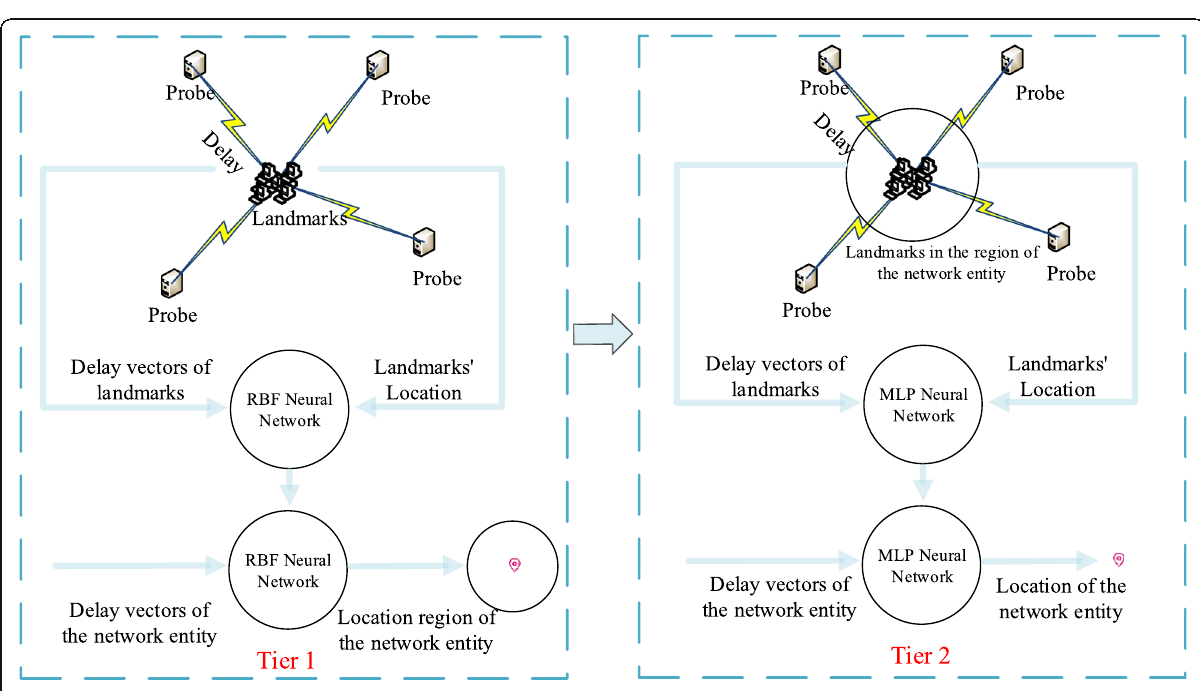
Fig. 2 Schematic diagram of TNN